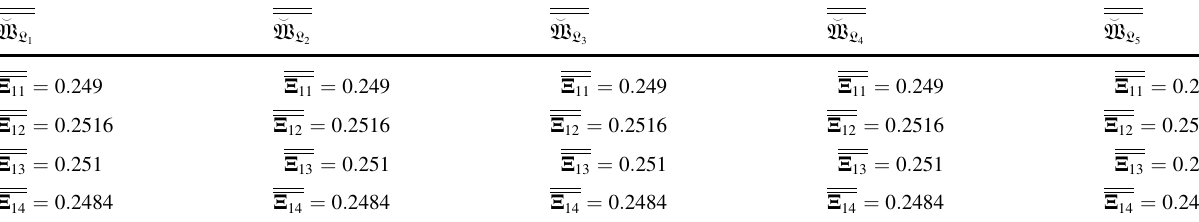
Table 5 The values of N s j